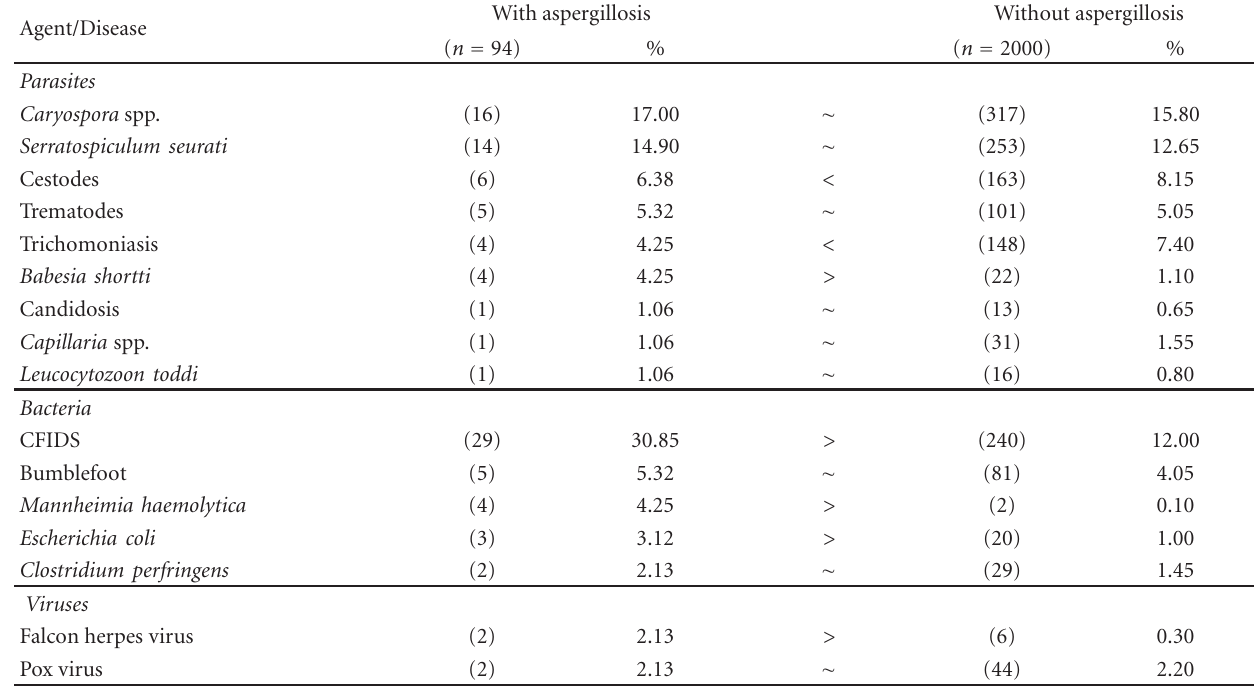
Table 2: Comparison between prevalences of aetiologic agents and diseases found in falcons with and without aspergillosis. With aspergillosis Without aspergillosis Agent/Disease Parasites Caryospora